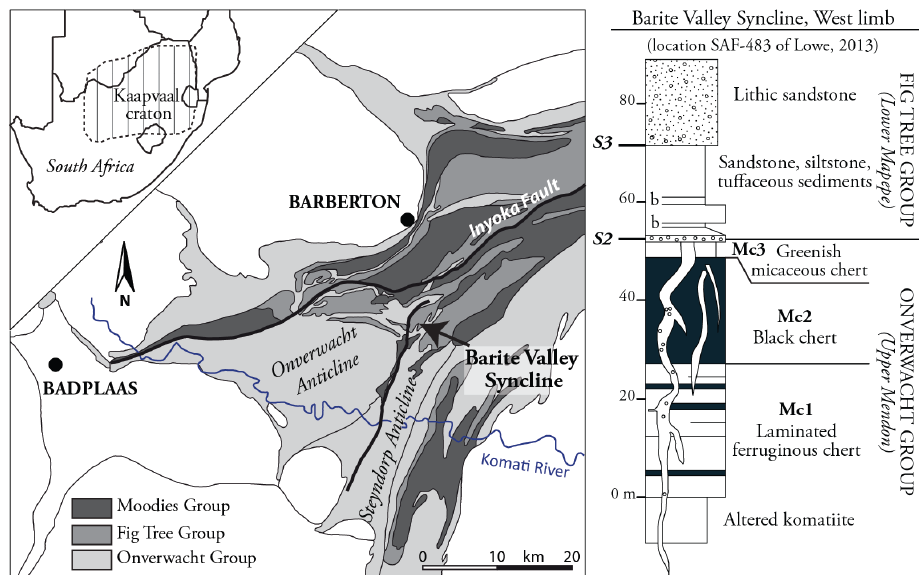
Figure 1. (Left) Simplified geological map of the Barberton Greenstone Belt and location of the Barite Valley Syncline. (Right) Stratigraphy of the western limb of the Barite Valley syncline, modified from Lowe (2013). The Onverwacht to Fig Tree transition is marked by the spherule bed S2 (Lowe and Byerly, 1986b) below which the dike complex of this study is found. The dikes begin in the sedimentary units M3c and M2c, cut through M1c and extent down to the Si-metasomatized komatiitic flows. “b” indicates the position of barite